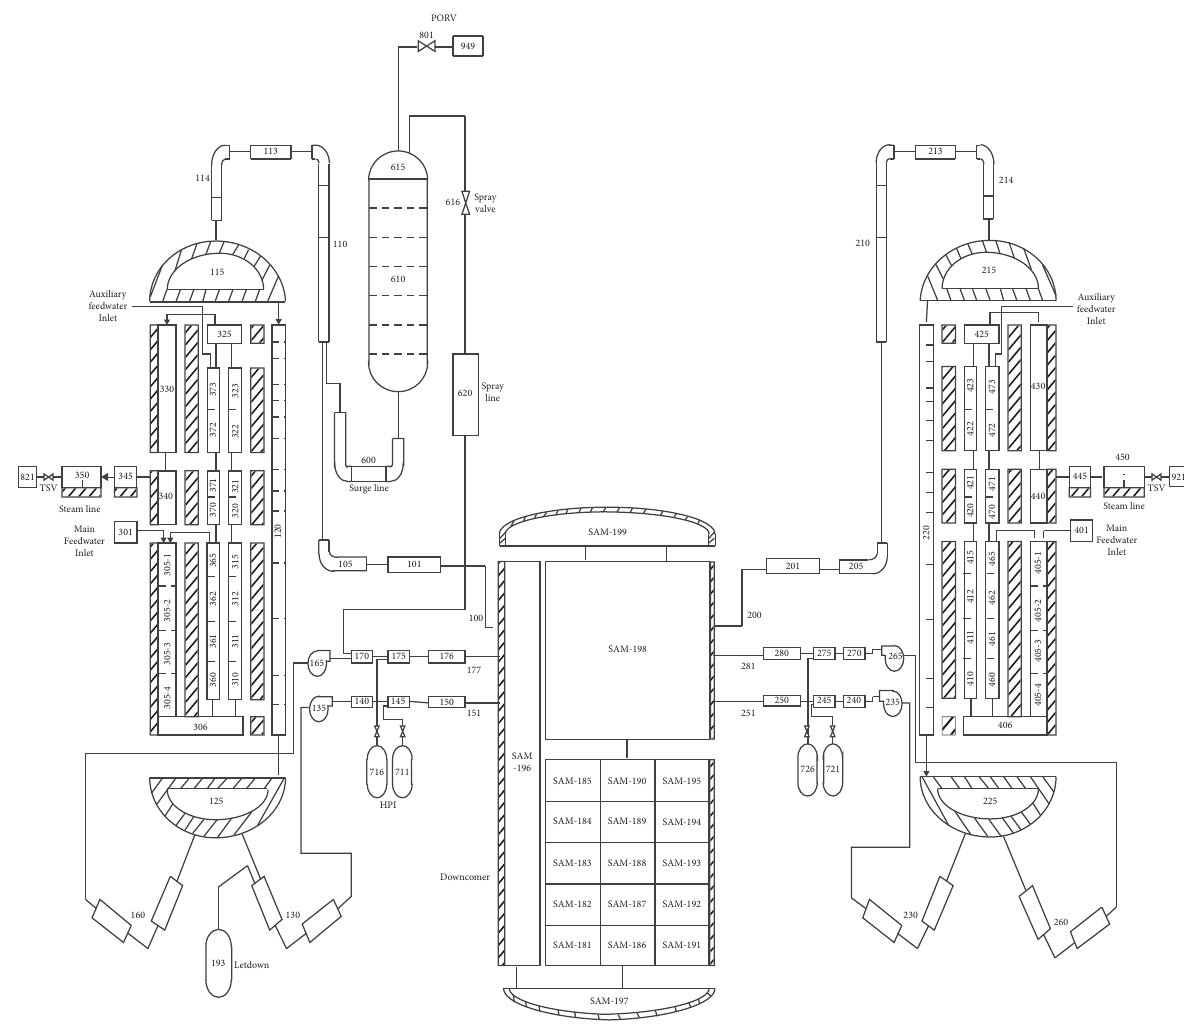
Figure 3: CINEMA modalization for